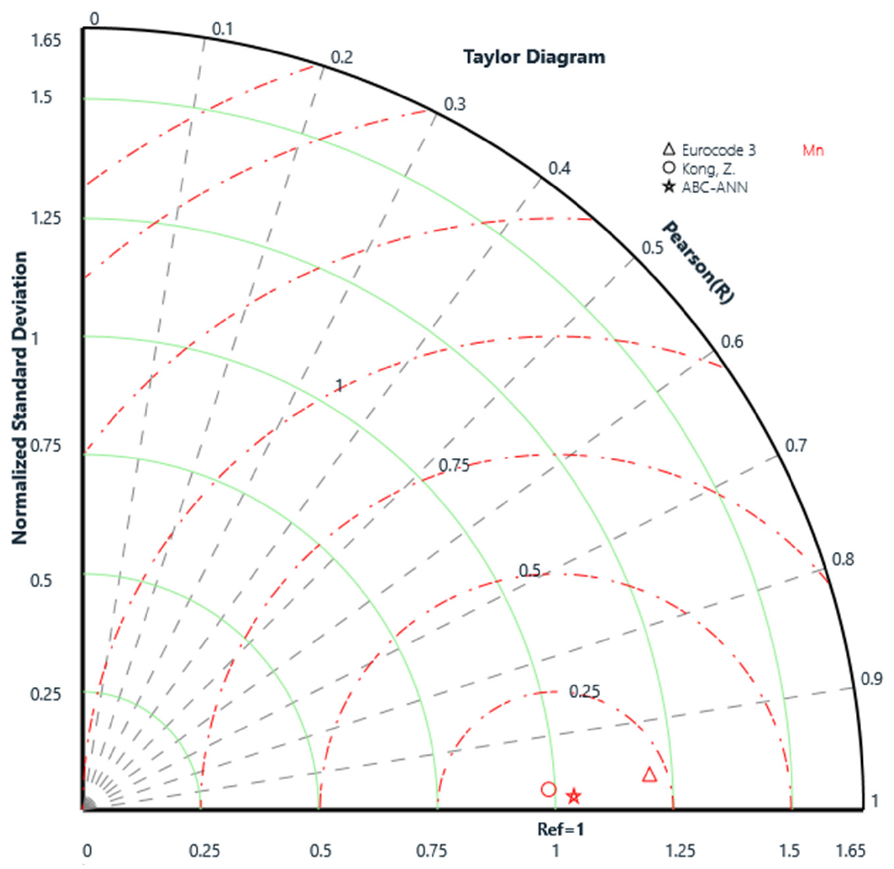
Figure 11. Taylor diagram visualization of model performance, in terms of M n predictions.